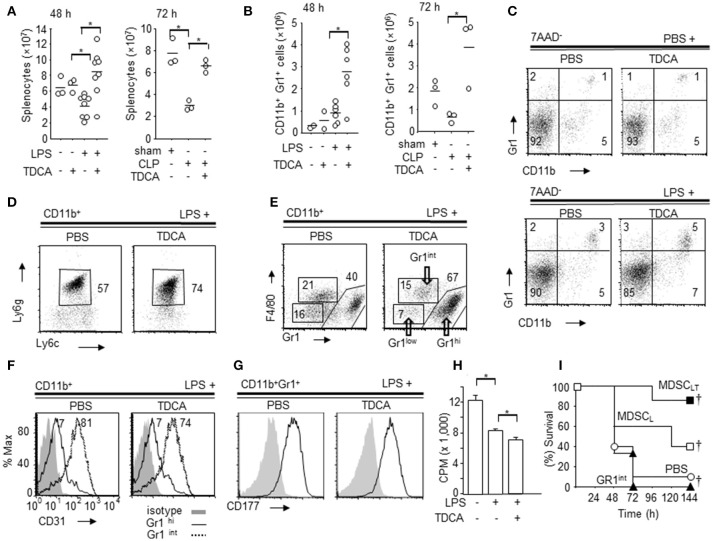
Phenotype of splenic CD11b+Gr1hi cells increased by TDCA. (A) The absolute numbers of spleen cells from B6 mice at 48 h post LPS injection (left, Data pooled from 5 independent experiments) or 72 h post CLP (right) by Trypan blue exclusion assay. (B) The absolute number of splenic CD11b+Gr1hi cells from B6 mice at 48 h post LPS injection (left) or 72 h post CLP setting (right). (C) Representative FACS plots of (B). (D) Representative FACS plots showing the expression of Ly6g and Ly6c on the subpopulation of CD11b+ cells. The percentage denotes the % of Ly6cintLy6g+ cells among CD11b+ cells. (E) Representative FACS plots showing the expression of Gr1 and F4/80 on CD11b+ cells. (F) Representative FACS plots showing expression of CD31 on CD11b+Gr1hi cells (solid line) and CD11b+Gr1int cells (dotted line) from the LPS+PBS group and LPS+TDCA group. Filled histograms denote the isotype control. (G) Expression of CD177 on CD11b+Gr1hi cells. Filled histograms denote the isotype control. (H) [H3]Thymidine-incorporation of T-cells following CD3 + CD28 ligation was measured after co-culture with CD11b+Gr1hi cells (E:T = 1:5) purified from spleen of mice injected with PBS + PBS, LPS + PBS, or LPS + TDCA. The data are expressed as the mean count per minute (cpm) ± SEM of triplicate assays pooled from 3 independent experiments. (I) The survival of mice after adoptive transfer of CD11b+Gr1hi cells (1 × 105 cells/mouse) purified from the LPS + TDCA group (■, n = 7, MDSCLT) or the LPS + PBS group (□, n = 5, MDSCL). CD11b+Gr1int cells (▴, n = 3) were purified from mice in the LPS + TDCA group. The thin horizontal lines on the top of the FACS plots indicate the gates used in the FACS analysis, and the thick horizontal lines are the experimental groups treated with LPS or PBS. The gating strategies are shown in Figures S7~S12. Data shown are pooled from 3 independent experiments with 1~3 mice per experiment otherwise denoted. Representative FACS plots of 3 independent experiments. †p < 0.05 using Kaplan-Meier survival analysis and the log-rank test between groups. *p < 0.05 by Student's two-tailed t-test.